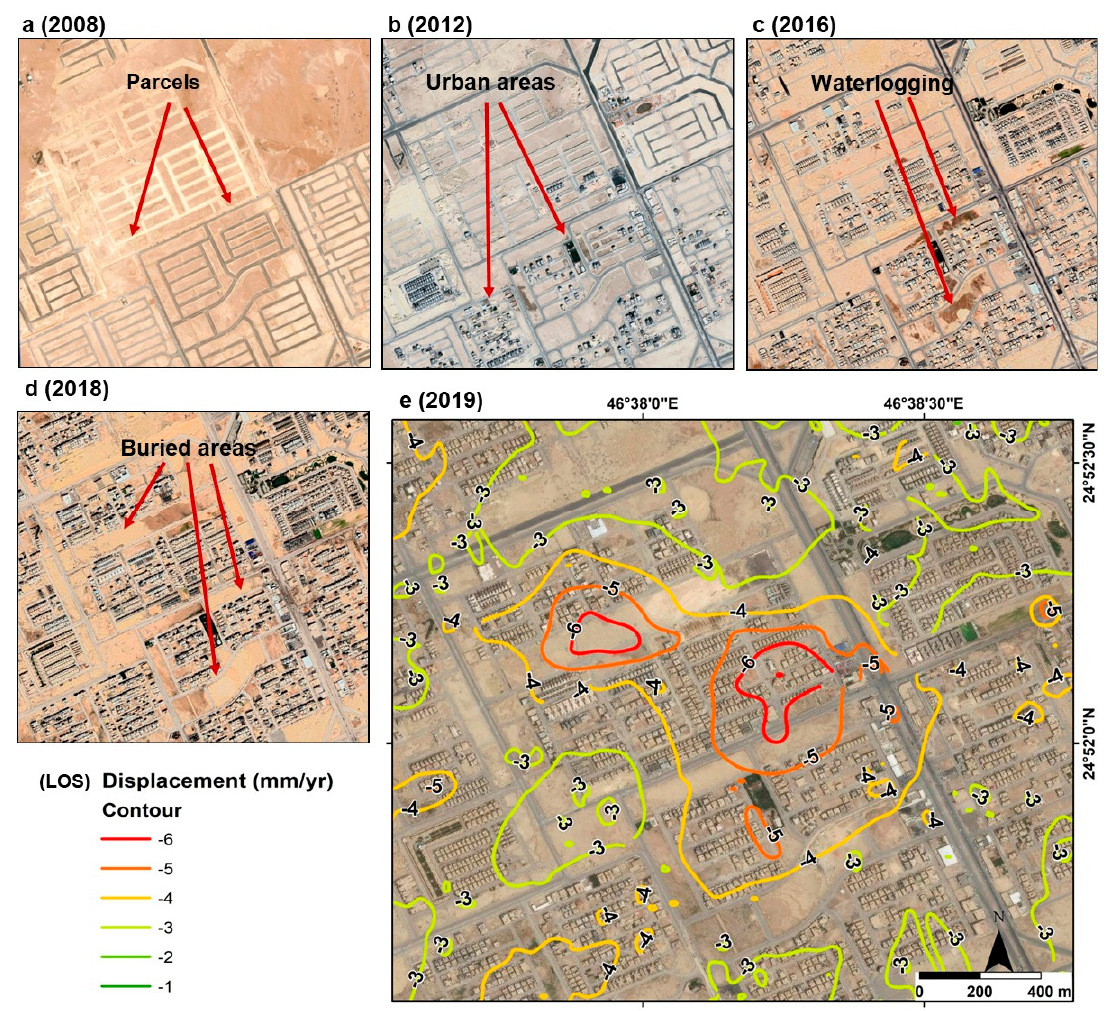
Figure 8. Temporal Google Earth images (2008 to 2018), ArcGIS online base map (2019), and LOS velocities over a lowland in An Narjis District (site L7). ( a ) Google Earth image acquired in April 2008. ( b ) Google Earth image acquired in December 2012. ( c ) Google Earth image acquired in October 2016. ( d ) Google Earth image acquired in November 2018. ( e ) LOS deformation rates plotted over the 2019 ArcGIS online base map.